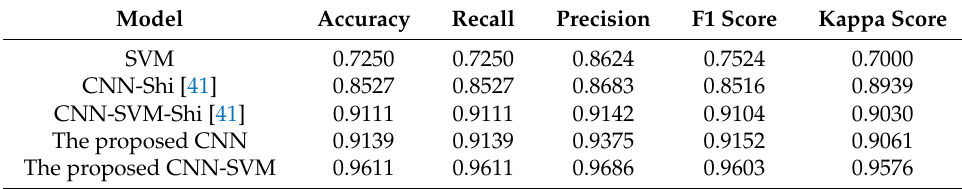
Table 4. Results of five evaluation metrics for classifications by five